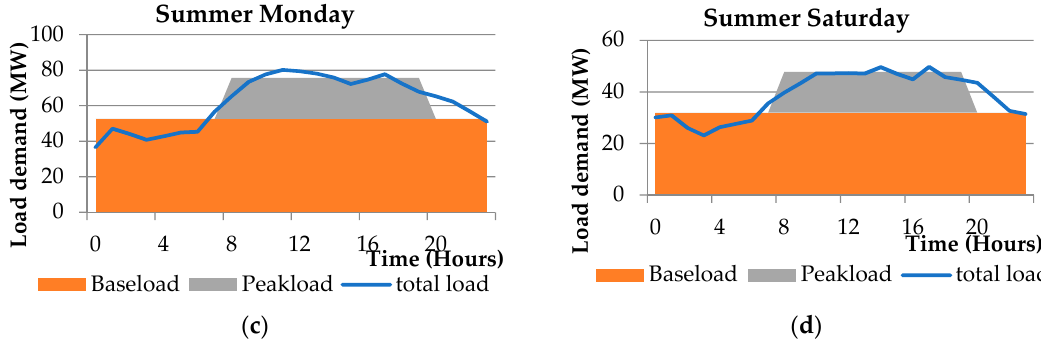
Figure 7. Adapted daily load profile of the base and peak loads for the samples of the Day-Ahead